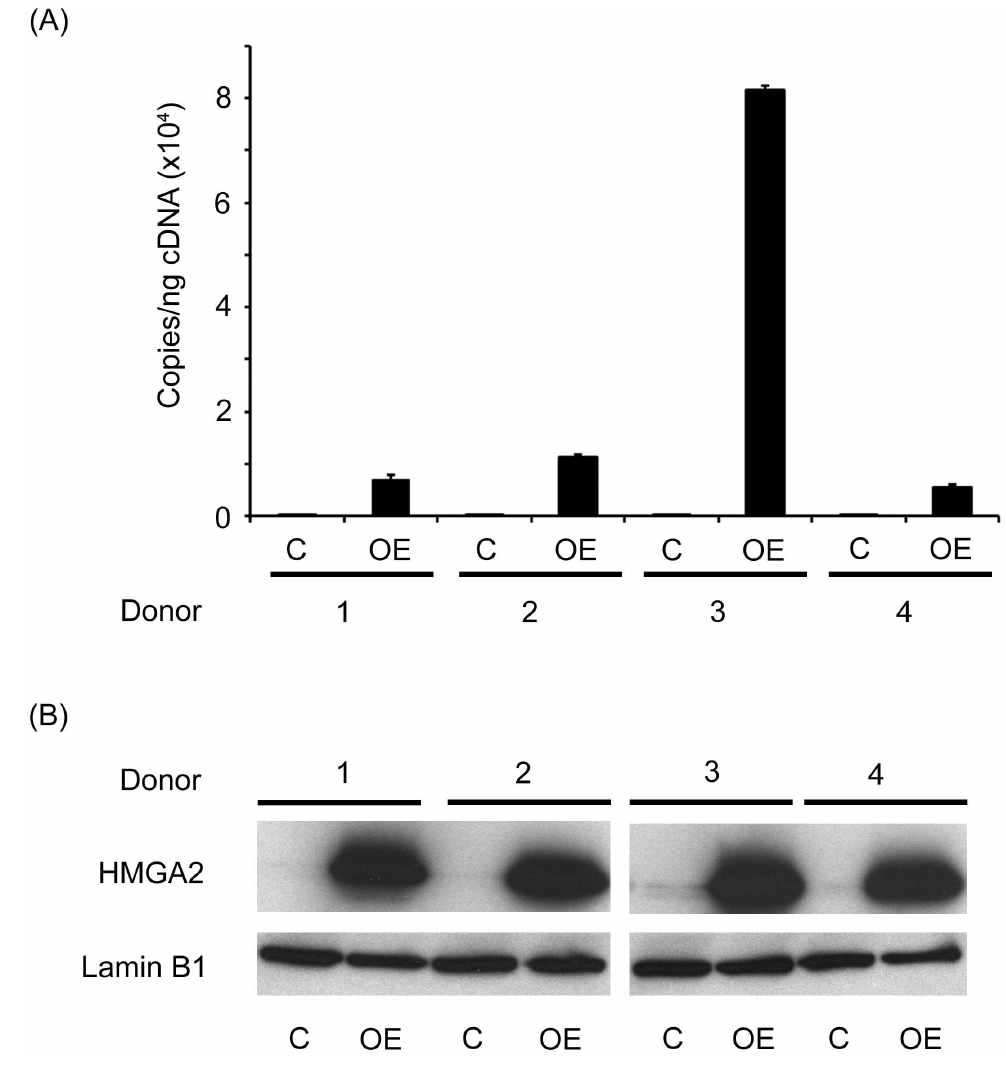
Open bars represent empty vector control and black bars represent HMGA2-OE. Four independentdonors were performed for each condition. (B) Western blot analysisof HMGA2 in the nuclear extracts from four independent donors upon HMGA2-OE comparedto transduction controls. Blot was probedwith anti-HMGA2 antibodyand Lamin B1 was used as loadingcontrol. C = empty vector control transduction; OE = HMGA2